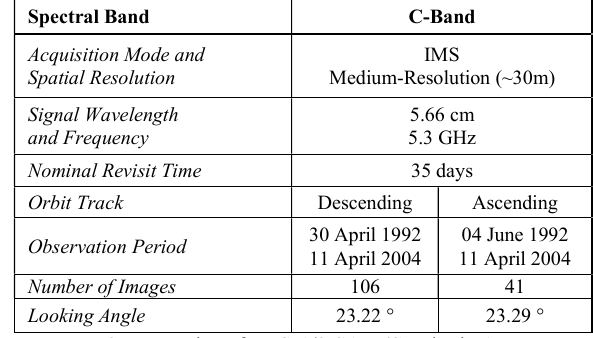
Table 2. Properties of ERS-1/2 SAR (Synthetic Aperture Radar) images.